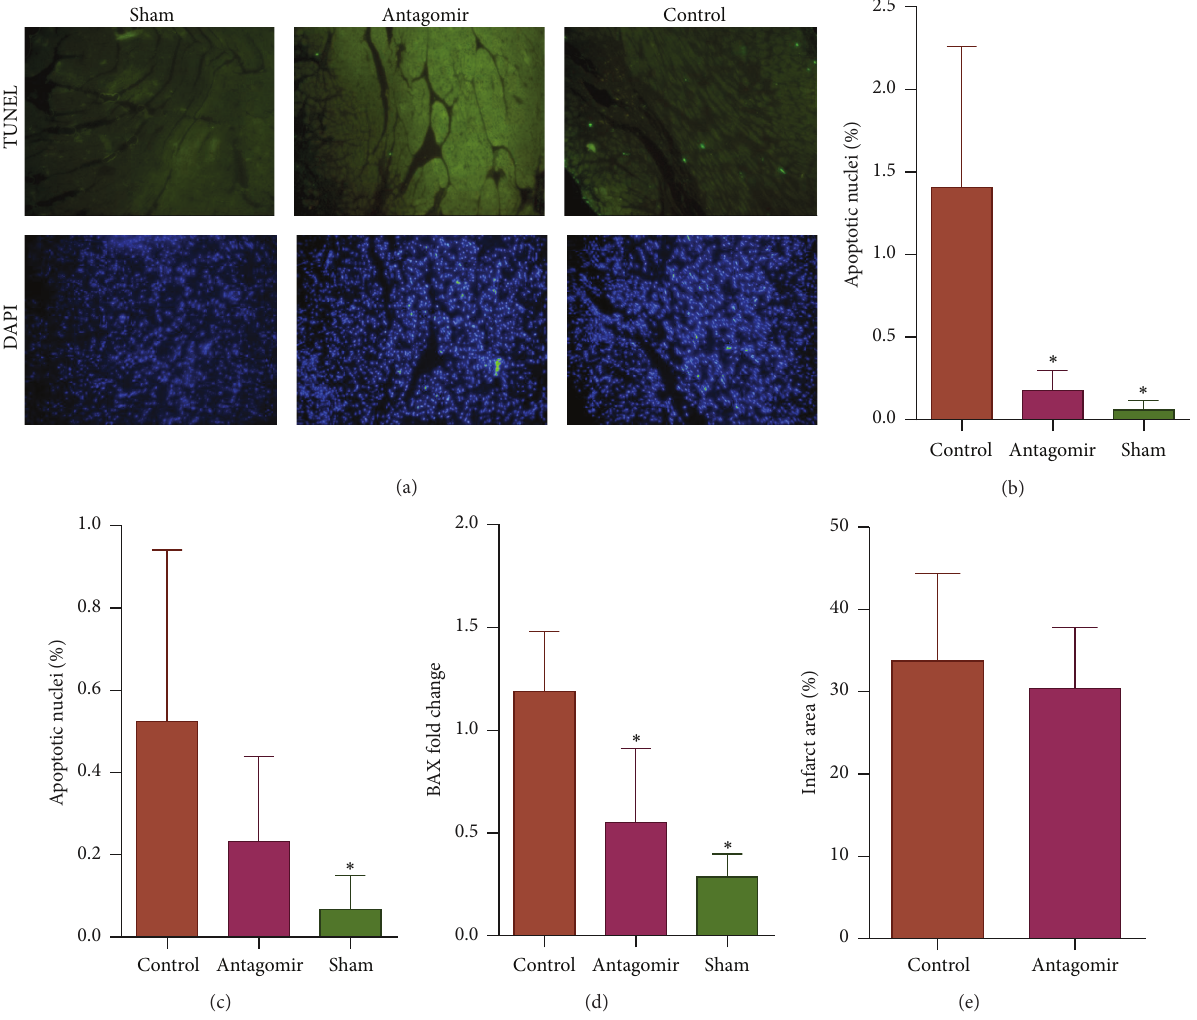
Figure 4: miR-208a silencing attenuates Bax expression and cardiomyocyte apoptosis at 28 days after MI ( ∗ 𝑝 < 0.05 ). (a) Representative tunnel stained images of the peri-infarct area showing that antagomir treatment decreased apoptosis in the peri-infarct area at day 28 ( × 20 objective). (b) Antagomir treatment significantly attenuated percentage apoptosis in the peri-infarct area ( 𝑛 = 3 per group). (c) Bar graph of percentage apoptotic nuclei in the noninfarcted area showing no significant difference between antagomir group and control ( 𝑛 = 3 ). (d) miR-208a antagomir downregulated Bax expression at 28 days after MI ( 𝑛 = 4 per group). (e) Although there was a trend towards reduction in infarct size in miR-208a antagomir treated mice compared to controls, this did not reach statistical significance ( 𝑛 = 3 per